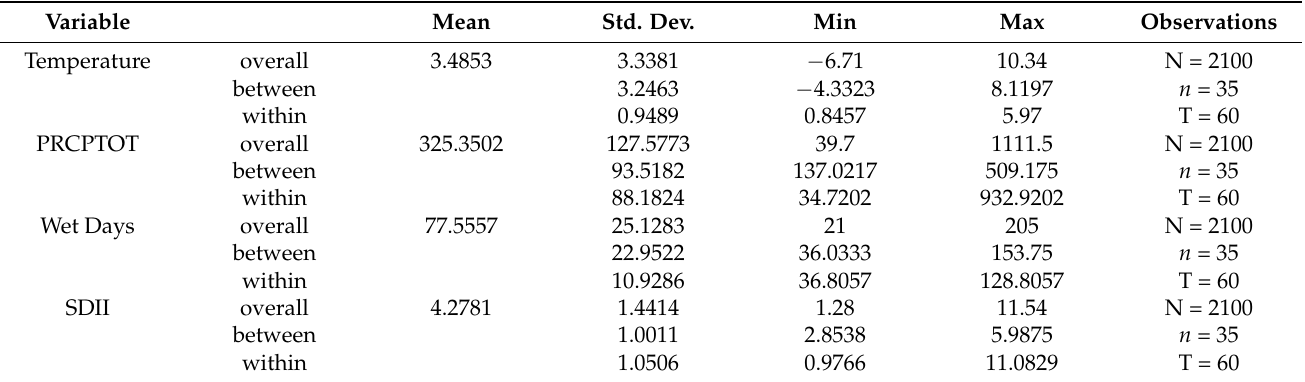
Table 2. Descriptive statistics of the study variables.